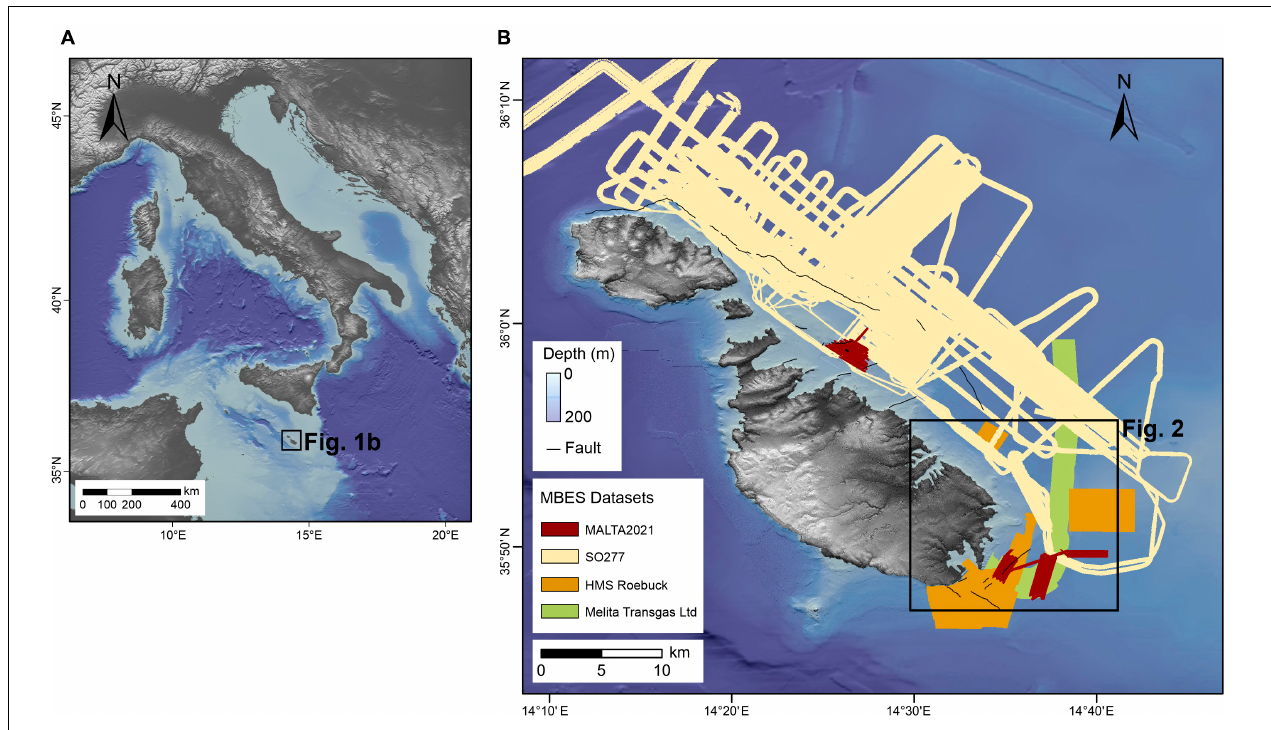
FIGURE 1 | Location map. (A) Overview map (upper left, ETOPO) shows the location of Malta, (B) available bathymetric data from the seafloor surrounding the Maltese Island, research area for this study is marked with a red box. “© Crown Copyright and/or database rights. Reproduced by permission of The Keeper of Public Records and the UK Hydrographic Office